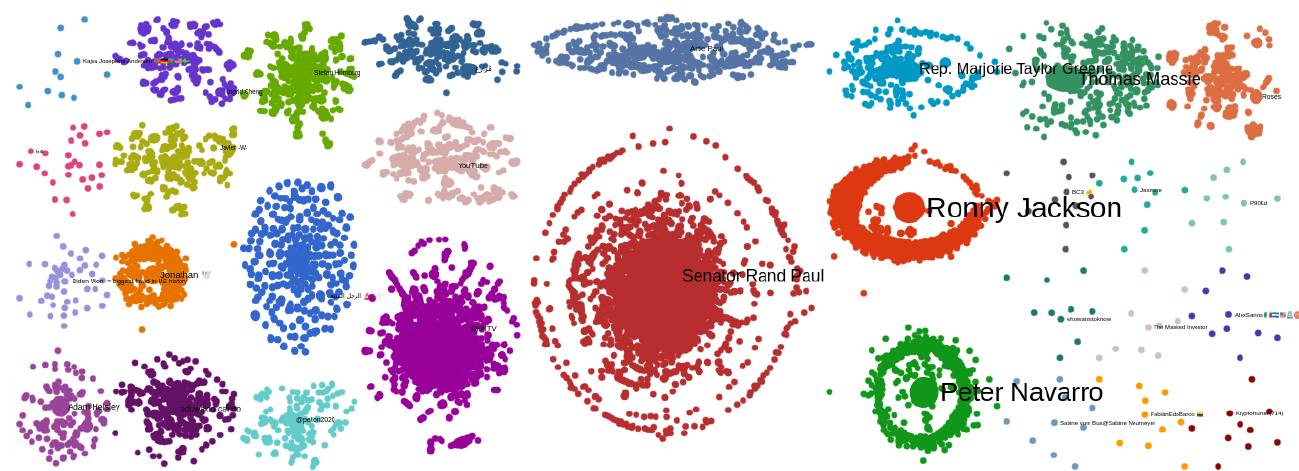
Figure 3. Visualization of example